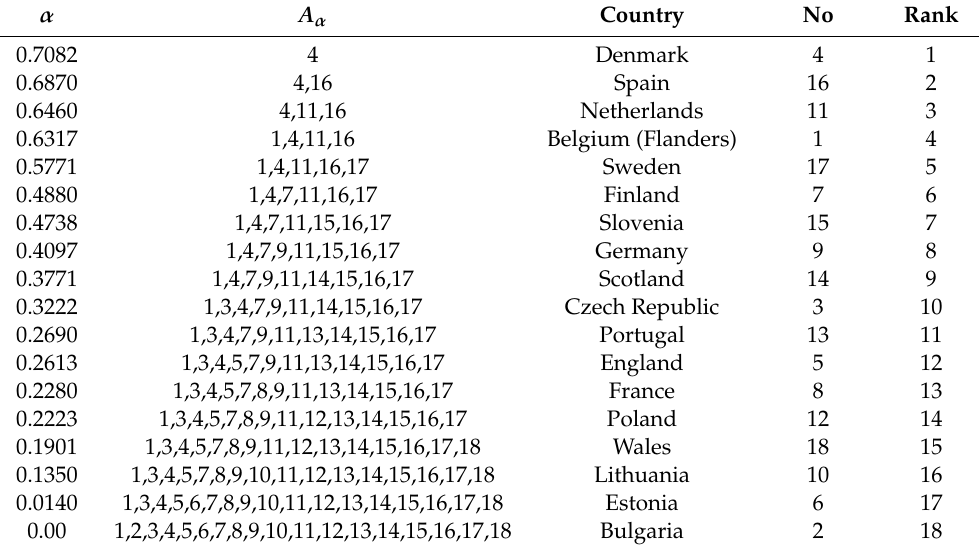
Table 6. α values, α -cuts and ranks of European countries for matrix R 2